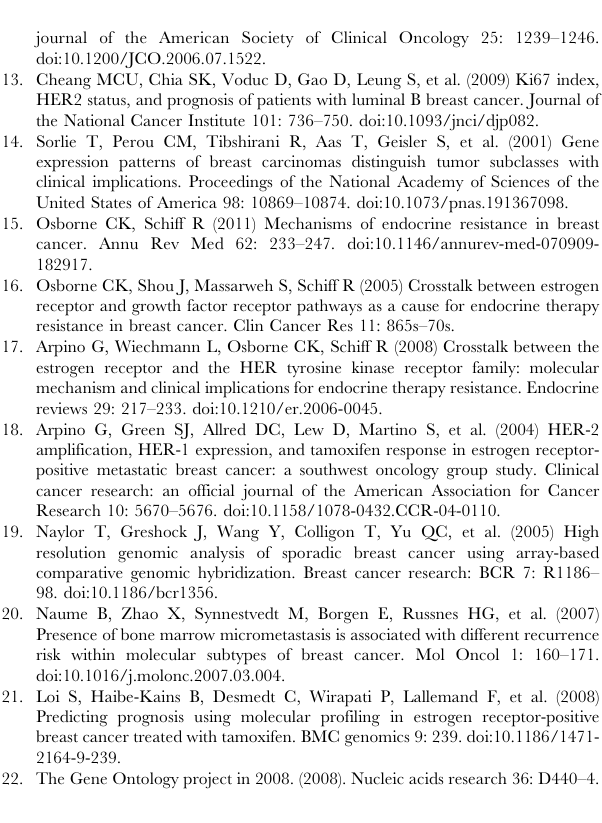
Table S5 Clinical information file. Excel 2003 file contain- ing clinical characteristics of the breast tumor samples used in the analysis of the combined gene expression data set from the study by Gyo¨rffy et al. [37]. Amplicon presence as found by the unsupervised outlier analysis are also listed. Table S6 Clinical information file. Excel 2003 file contain- ing clinical characteristics of the breast tumor samples used in the CGH data analysis. Amplicon presence as found by GISTIC is also listed for each sample. Table S7 Sample correlations between amplicons 17q12, 17q22, 8p11.2 and 8q24.3 in an independent CGH array data set. Phi coefficients measuring the strength of association between amplicons 17q12, 17q22, 8p11.2 and 8q24.3 in the test CGH dataset GSE22133. The last column lists the percentage counts of ER + samples with the associated amplicons. Highlighted in bold are correlation values significant at P , 0.01 except for self